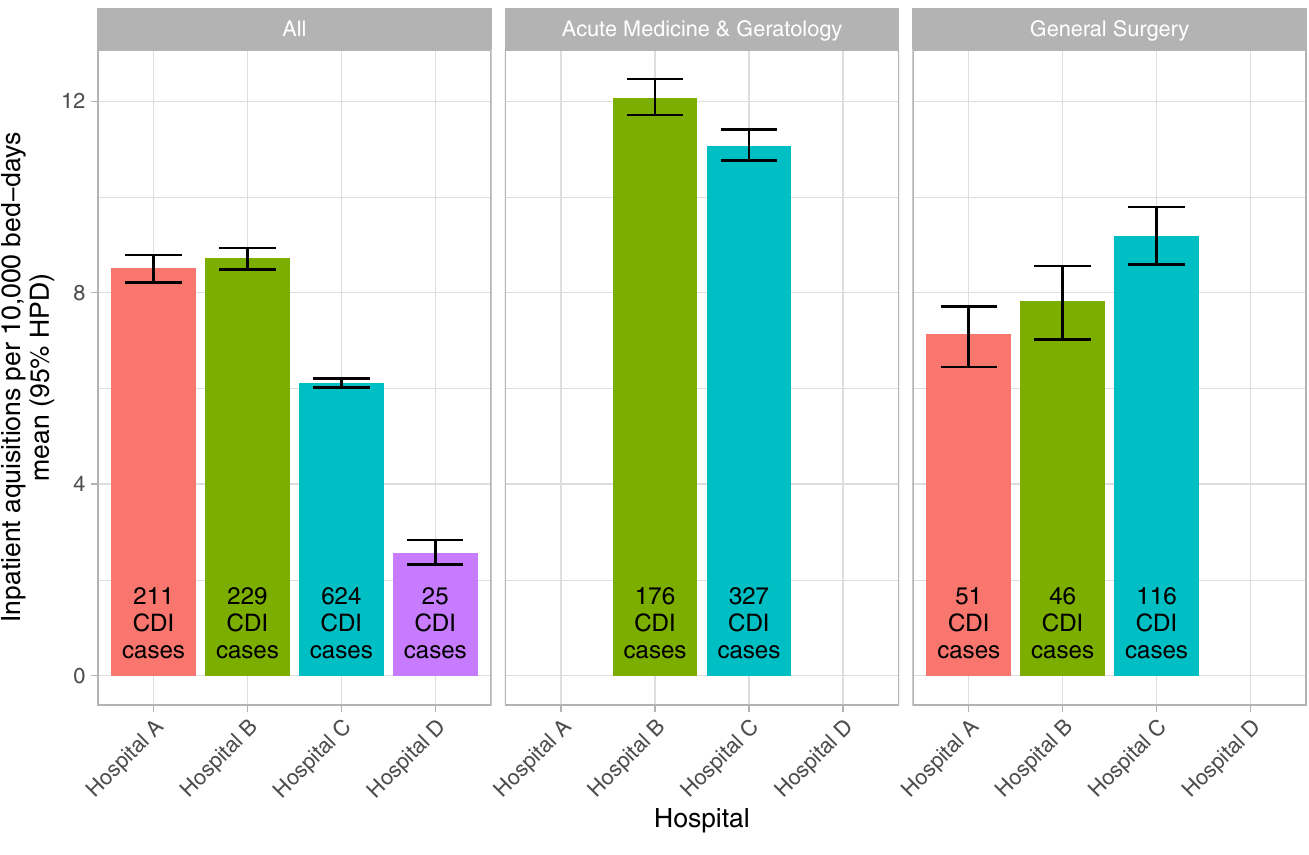
Fig 7. Inpatient C . difficile acquisition by